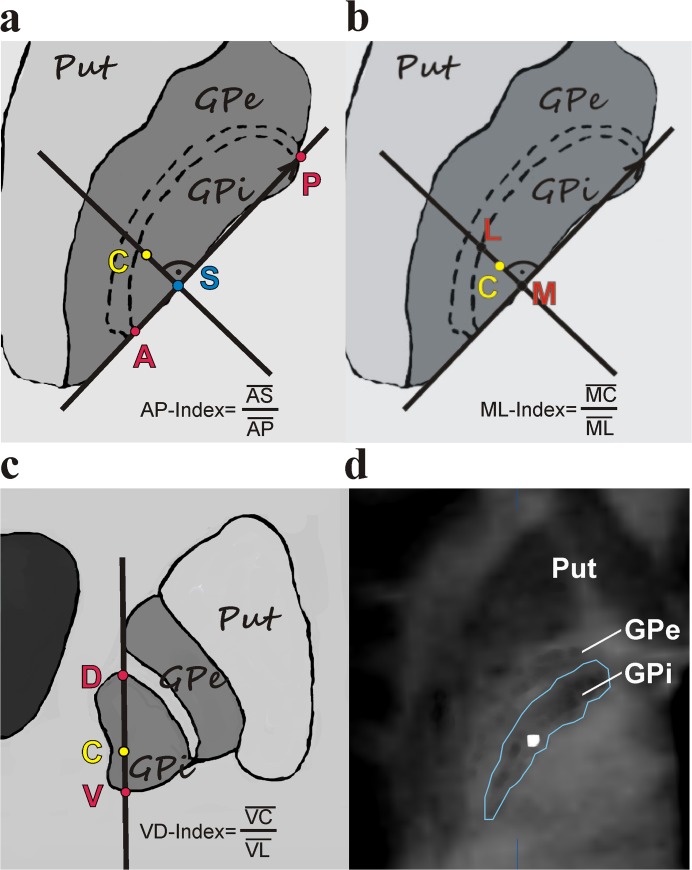
Determination of the AP-, ML- and VD-Index of the active contact C.A: A line between the most anterior (A) and posterior (P) points of the GPi constitutes the AP-line. Another line through the active contact C and perpendicular to AP intersects the AP-line in S. The AP-Index can be calculated as AP-Index = AS/AP. B: The medial (M) and lateral (L) point of the GPi are located on a line perpendicular to the AP-line crossing the active contact C. The ML-Index can be calculated as ML-Index = MC/ML. C: The ventral (V) and dorsal (D) point of the GPi are located on a line perpendicular to the ML-line crossing the active contact C. The VD-Index can be calculated as VD-Index = VC/VD. D: An overlay of the postoperative CT-scan at the level of the active contact and the MDEFT MRI sequence shows the border of the GPi after segmentation reveals the position of the active contact in relation to the anatomical borders of the GPi.